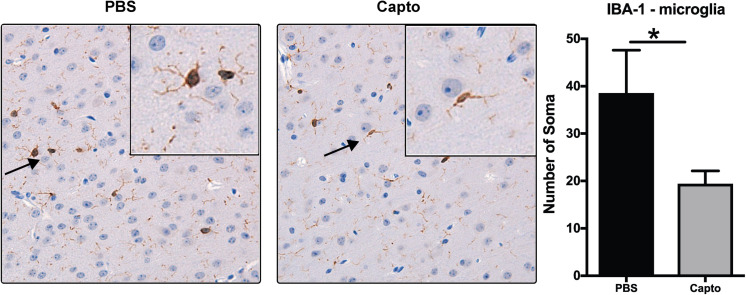
Captopril reduces microglial activation in the brain. Young MRL/lpr mice treated with captopril (i.p.) were perfused at end of treatment and brain tissue was harvested, paraffin embedded and analyzed for IBA-1 expression by chromagen (DAB) staining and IBA-1 staining in the PBS and captopril treated groups. IBA-1 staining of brain microglia shows more activation in PBS-treated MRL/lpr mice than in captopril-treated mice. Inset shows 40x magnification of the cortex region showing activated microglia with retracted processes and bigger cell bodies in PBS- treated mice vs. less activated microglia in captopril-treated mice. Cells stained for IBA-1 (brown) were counted in each of 6 fields on each slide for each mouse and averaged; n = 3–5 mice/group. Slides were coded and read in a blinded fashion to avoid any bias in interpretation. Unpaired t test statistical analysis was performed and p < 0.05 was considered significant; *p < 0.05.